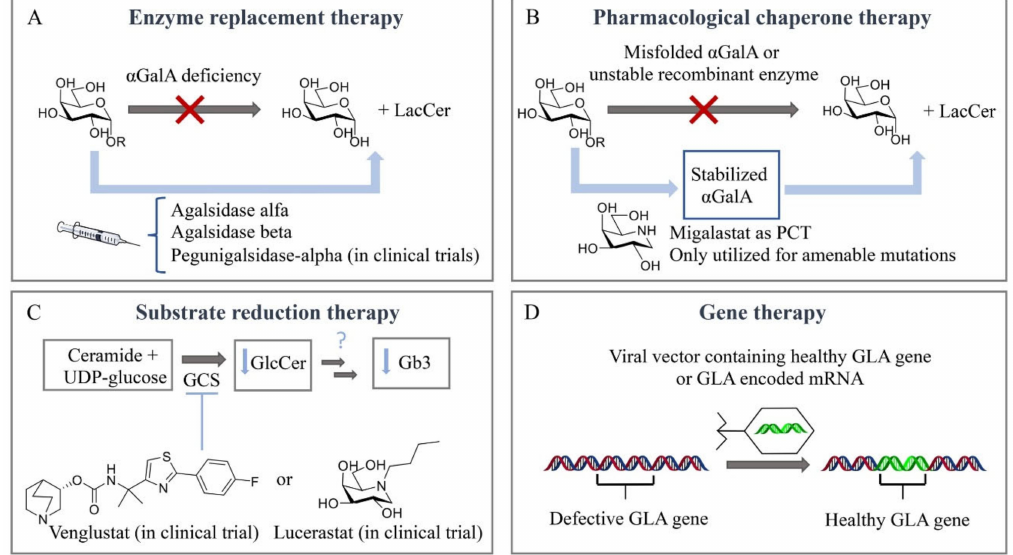
Figure 3. Therapeutic strategies for treatment of Fabry disease. ( A ) Enzyme replacement therapy (ERT). ( B ) Pharmacological chaperone therapy (PCT). ( C ) Substrate reduction therapy (SRT). ( D ) Gene